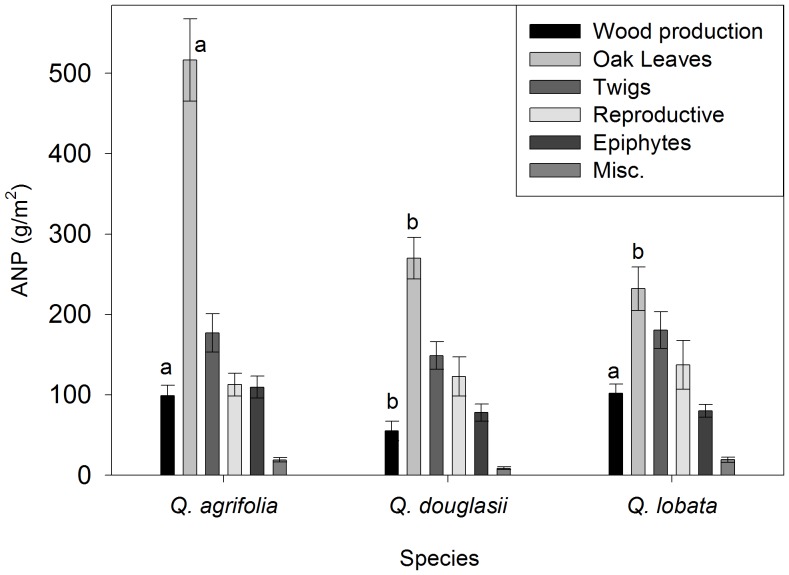
Five-year average (± SE) ANP of Quercus agrifolia (n = 13), Q. douglasii (n = 13 and Q. lobata (n = 14).Reproductive litterfall consisted of acorns, acorn caps, aborted acorns (including unfertilized flowers) and catkins. Epiphytes included lichens, mosses and mistletoe. Miscellaneous includes insects, insect frass, and unidentifiable organic material. Significant differences among species include oak leaves (one-way ANOVA, F
2,37 = 18.1, P<0.001) and woody increment (F
2,37 = 5.5, P<0.01). Different letters denote P<0.05 in a Tukey post-hoc comparison among species.